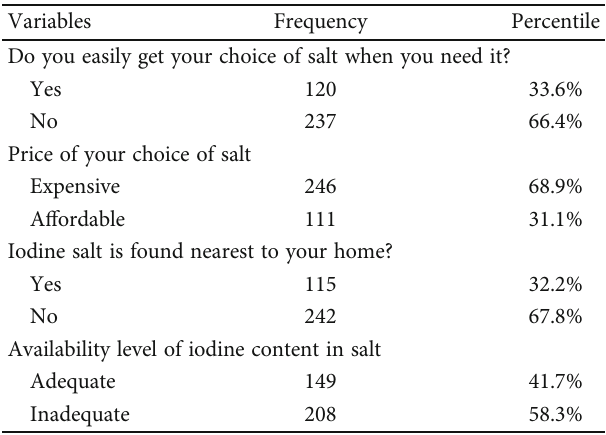
Table 4: Frequency distribution of respondent ’ s availability of iodized salt in the study